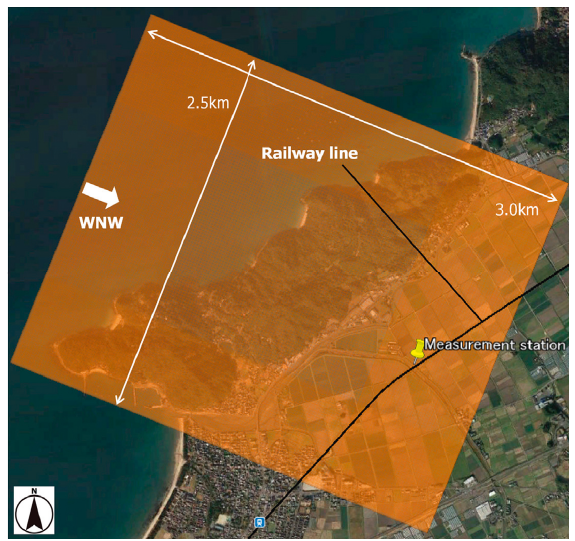
Figure 11: Calculation area when grid resolution in the horizontal direction was increased.